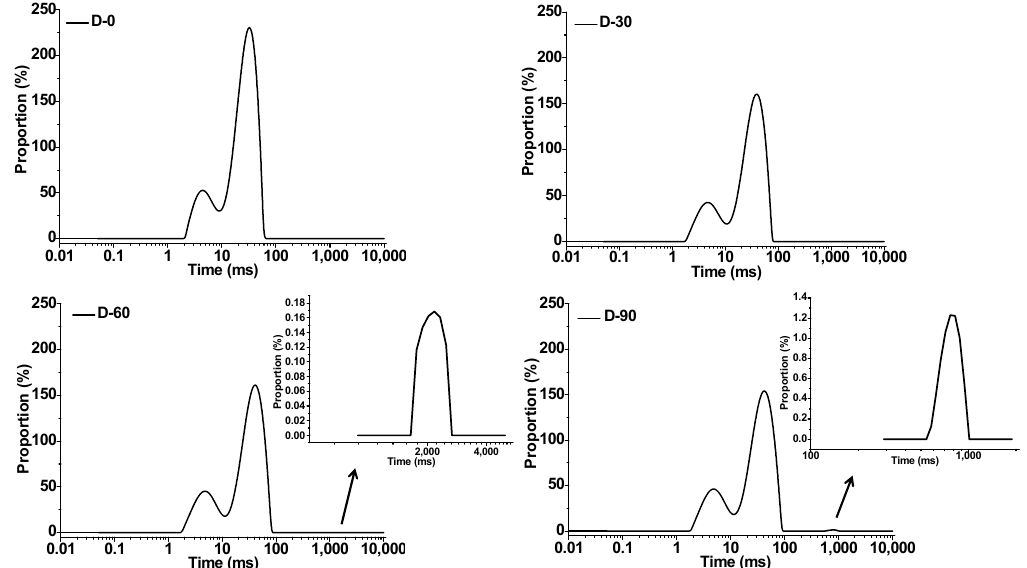
Figure 3. Effect of proofing on the continuous distribution of spin–spin relaxation time of CS–HPMC gluten-free